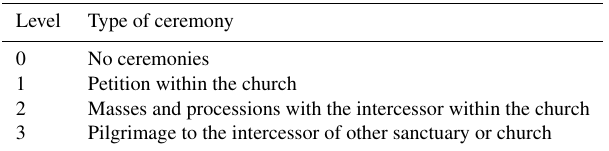
Table 3. Rogation levels according to the type of ceremony cele-